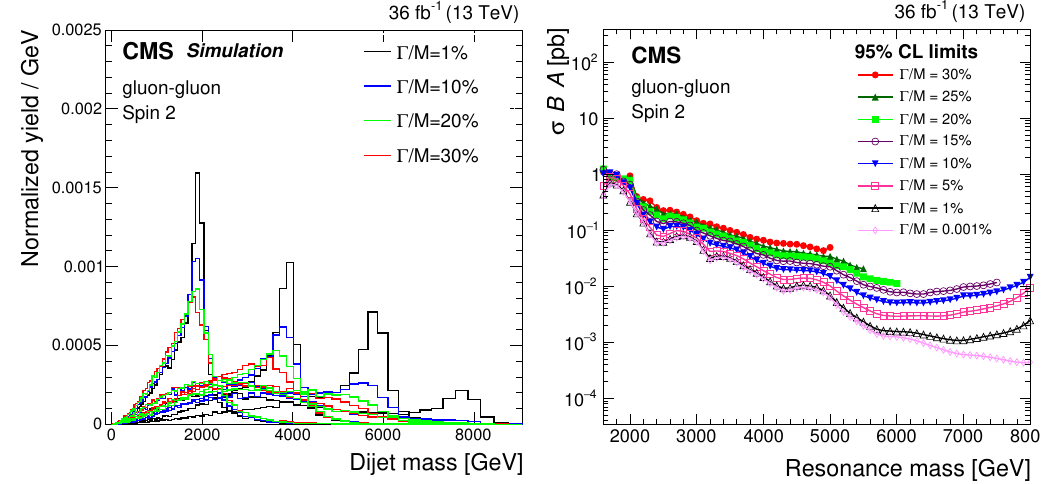
Figure 17 . The resonance signal shapes (left) and observed 95% CL upper limits on the product of the cross section, branching fraction, and acceptance (right) for spin-2 resonances produced and decaying in the gluon-gluon channel are shown for various values of intrinsic width and resonance mass. The reconstructed dijet mass spectrum for these resonances is estimated from the pythia 8 MC event generator, followed by the simulation of the CMS detector response.